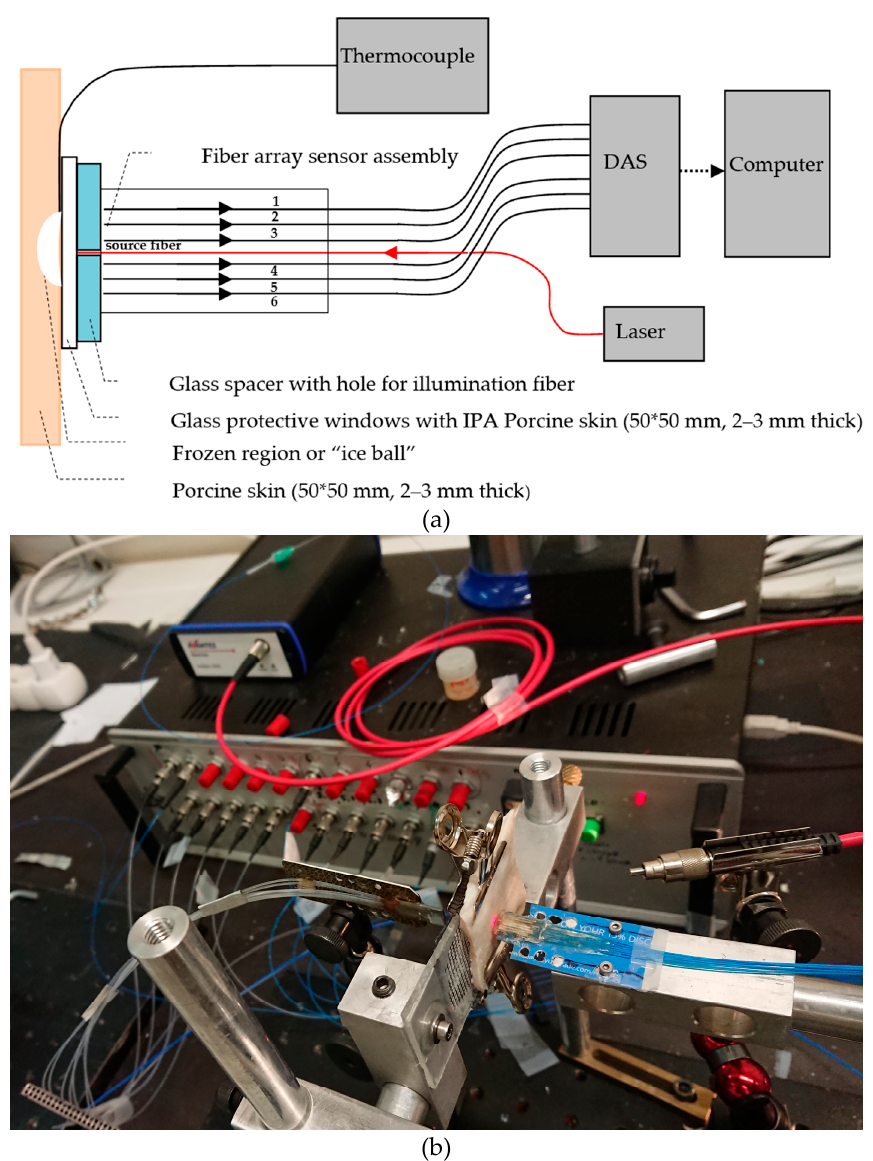
Figure 1. ( a ) Schematic diagram of top view of the fiber array sensor and experimental setup with thermocouple, laser source, and data acquisition system (DAS). ( b ) The fiber array sensor. The fiber array was set up horizontally, and light from each fiber was picked up by a photodiode in the detector unit. The depth of freezing was determined by analyzing the fluctuation of backscattered intensities measured during thawing and correlating it with transmission data obtained from the calibration procedure. To replicate body temperature, tissue samples were mounted on a heated platform. During data collection, the sensor head was in contact with the skin and allowed to thaw. In experiments using a hot plate, thawing took between 85 and 100 s, and the skin temperature rose from − 40 °C to +20 °C. The procedure was repeated multiple times on various skin samples and portions, with similar results, varying mostly in the overall duration of thawing due to variations in the application of